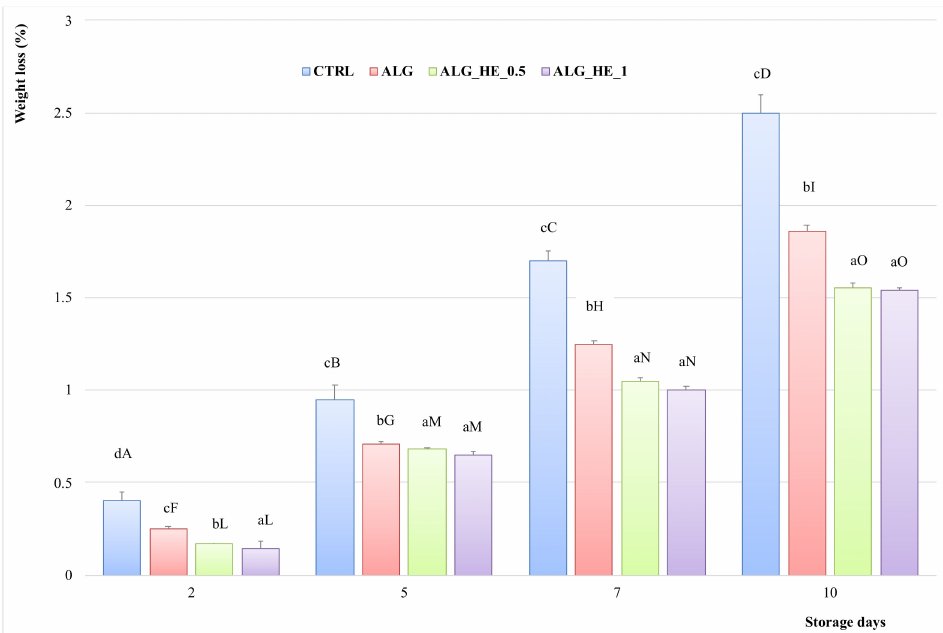
Figure 3. Percentage of weight loss (mean ± sd; n = 5) of fresh-cut kiwifruit underwent different treatments during storage at 4 ◦ C. CTRL, control samples; ALG, alginate samples; ALG_HE_0.5, samples coated with alginate added with 0.5% of hop extract; ALG_HE_1, samples coated with alginate added with 1% of hop extract. Different lower-case letters indicate significant differences ( p < 0.05) among treatments at the same storage time. Different upper-case letters indicate significant differences ( p < 0.05) in each treatment over the storage time.